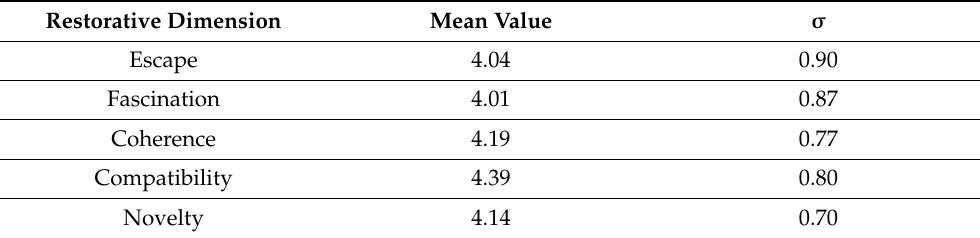
Table 3. Reliability of restorative dimensions measured with Crombach Alpha ( σ ). Restorative Dimension